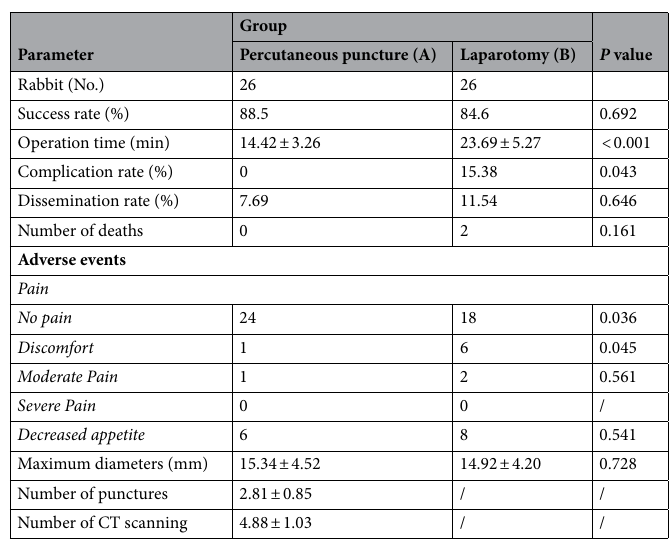
Table 2. Comparison of rabbit VX2 liver metastasis inducing in groups A and